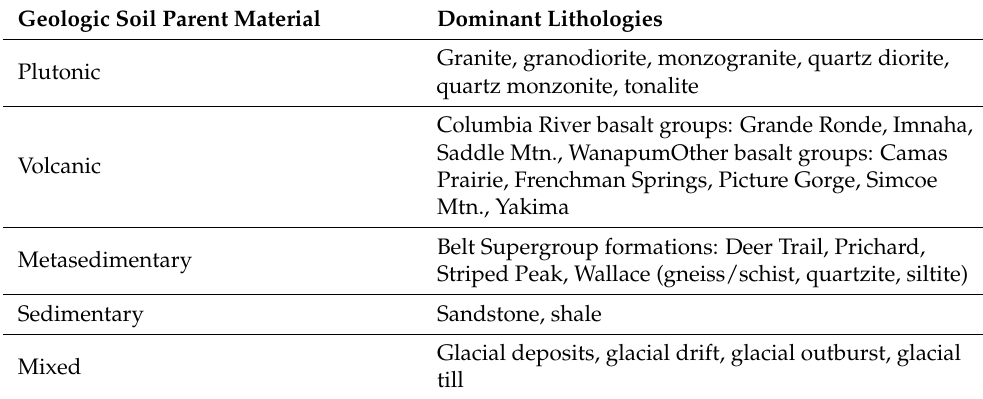
Table 1. Dominant lithologies found among broad geologic soil parent materials across the study region.